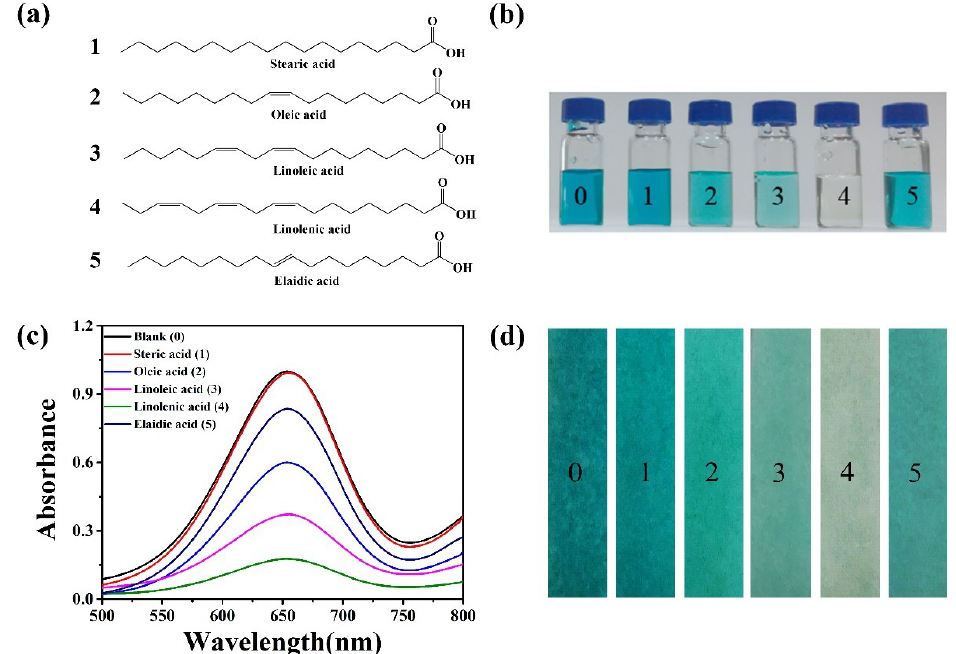
Figure 4. ( a ) Molecular structures of five FAs; ( b ) digital photo and ( c ) absorption spectra of Ag + -TMB sensing system towards five FAs (FAs concentration: 500 nM); ( d ) test papers towards five FAs. The meaning of numbers: 0 (blank), 1 (steric acid), 2 (oleic acid), 3 (linoleic acid), 4 (linolenic acid), 5 (elaidic acid).